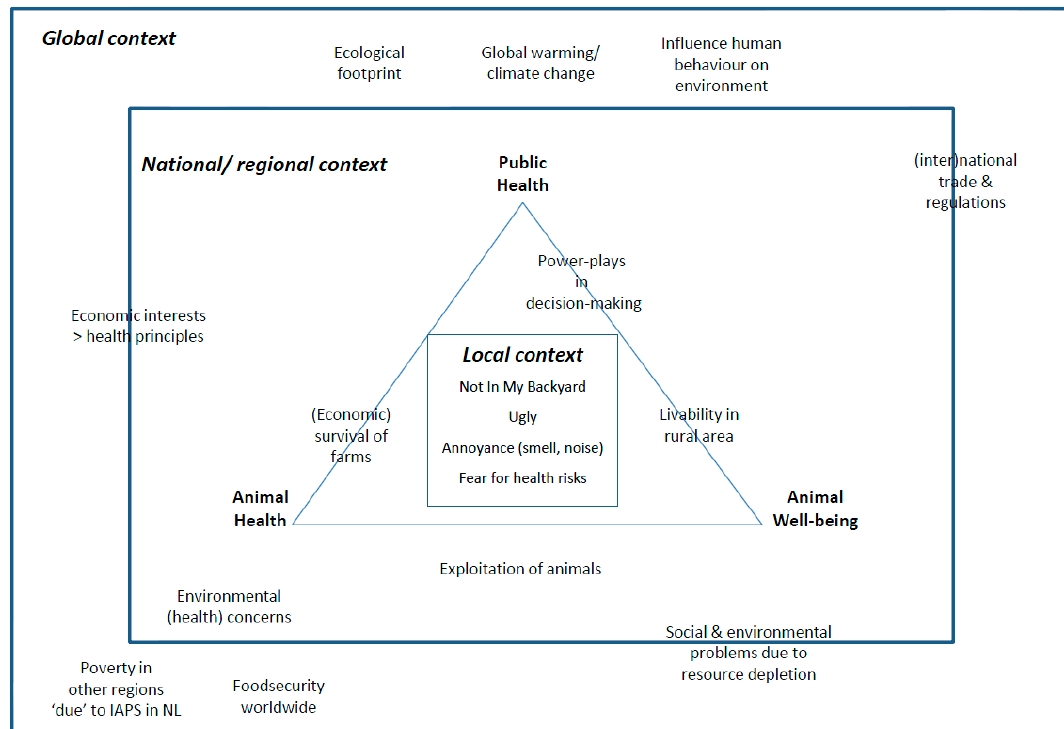
Figure 2. Scaling of societal concerns related to IAPS.